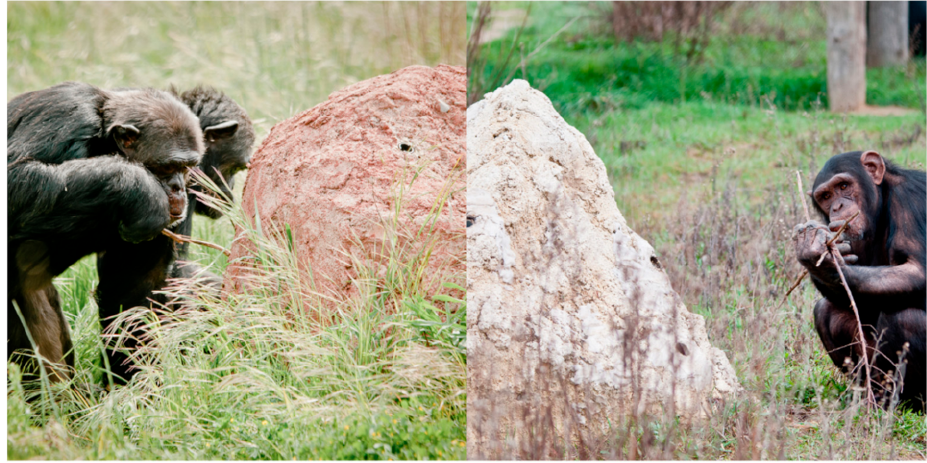
Figure 3. Termite mounds used during the treatment phase with the Mutamba ( right ) and Bilinga ( left ) chimpanzee groups. Credit: M.